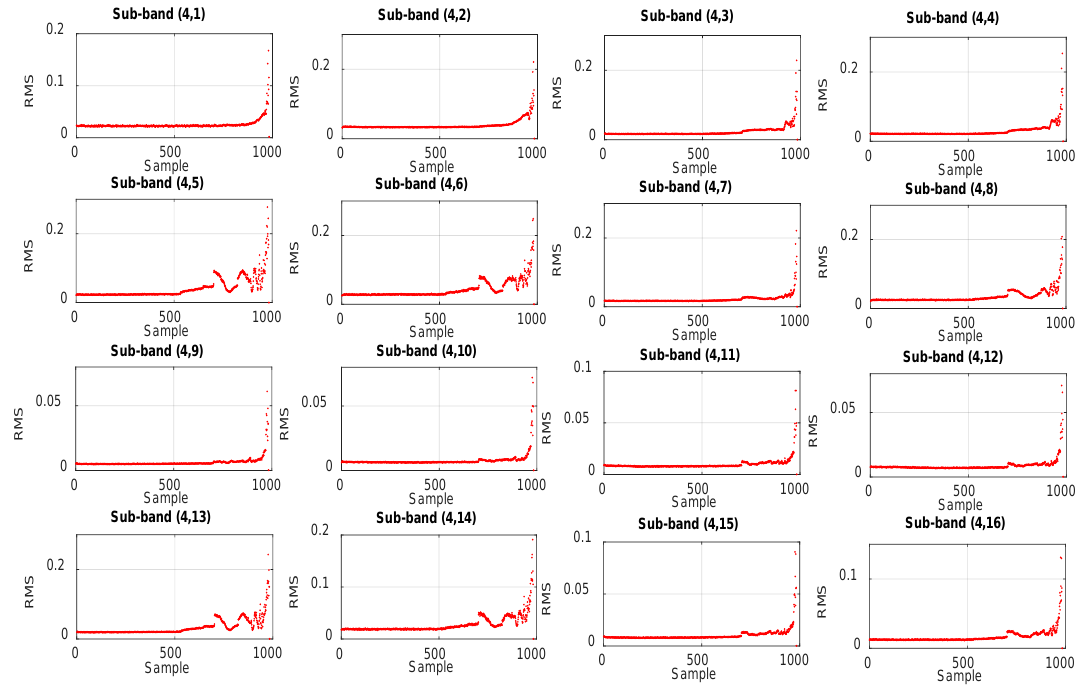
Figure 3. RMS trends extracted from 16 sub-bands of the vibration acceleration signals for bearing 1 of the second run-to-failure test of the IMS dataset, which fails owing to an outer race failure.